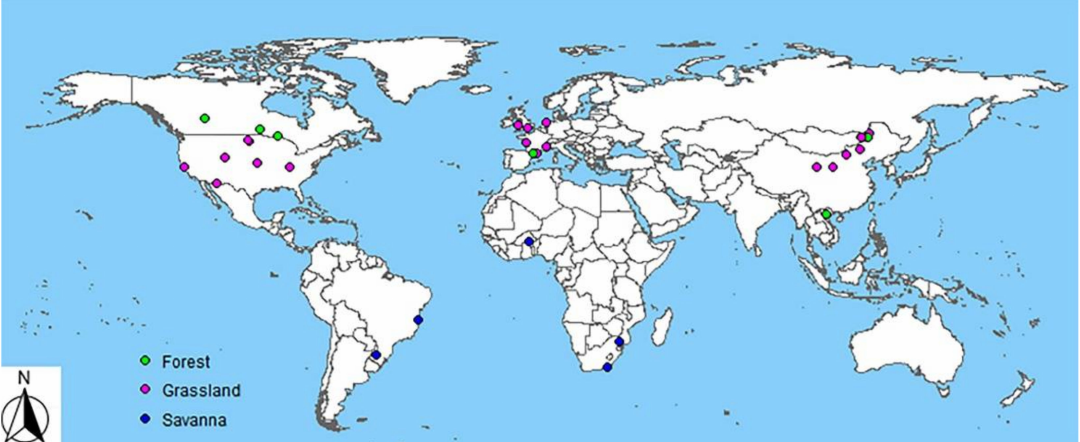
Figure 2. Map of the global distribution of studies from different